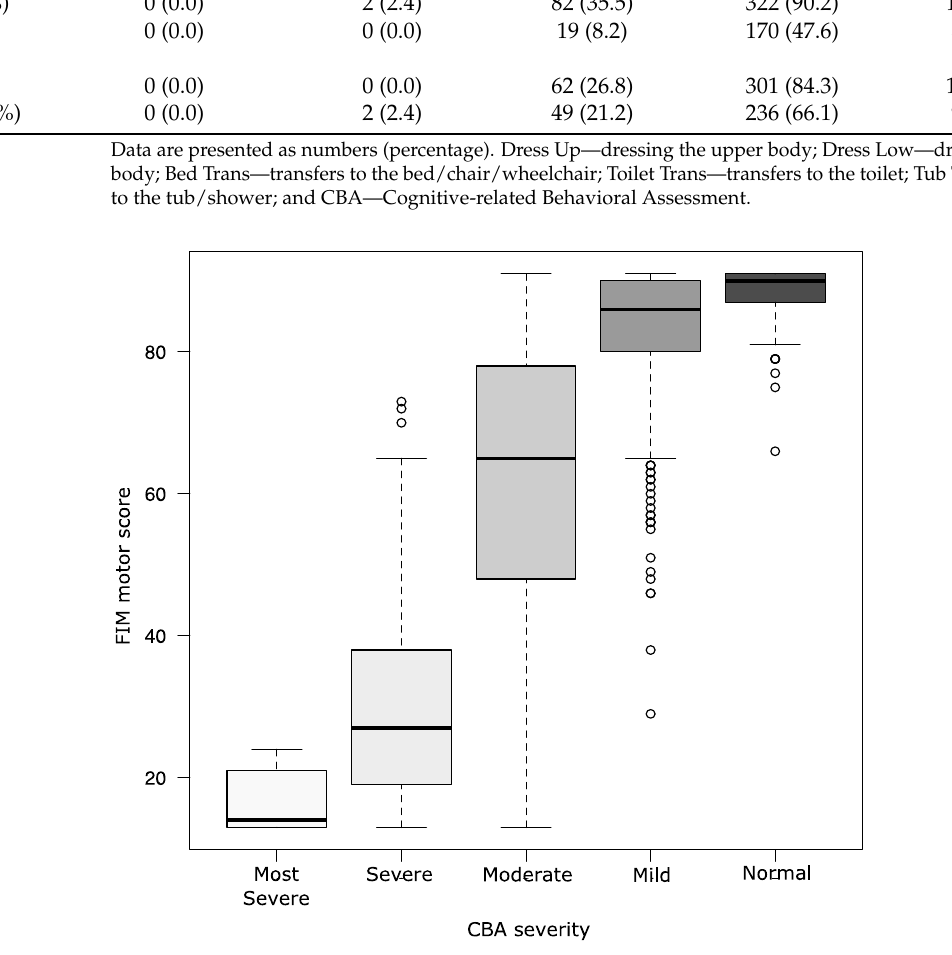
Figure 2. ADL ability score according to CBA severity. Summary data of FIM motor score, according to CBA severity: score of 30–29 indicating normal severity, 28–23 indicating mild severity, 22–17 indicating moderate severity, 16–11 indicating severe severity, and 10–6 indicating most severe severity. Data are represented as boxplots with median, min, and max values. The difference in FIM motor score was observed in all groups (Bonferroni correction to adjust for multiple comparisons). FIM—Functional Independence Measure; CBA—Cognitive-related Behavioral Assessment.